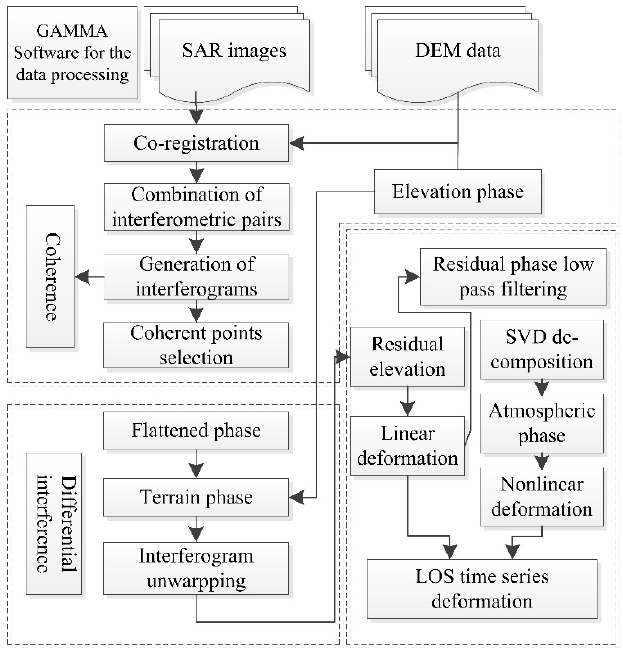
Figure 2. Workflow of SBAS-InSAR technology.